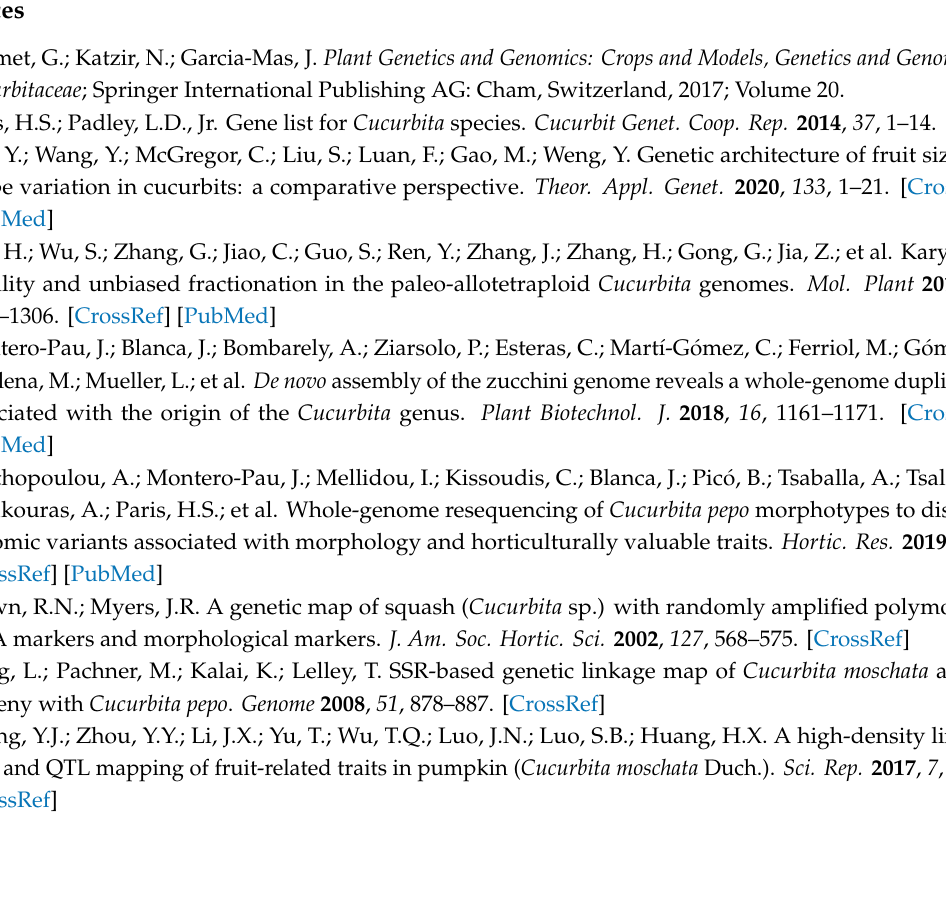
Figure S1: Trait for flesh color and cream-colored spots on the pericarp, Figure S2: Schematic representation of measurement of fruit-size related traits, Figure S3: Frequency distributions of the traits scored for the F 2 population of ‘TN 6’ × ‘Shishigatani’-K, Figure S4: A linkage map of the F 2 population (‘TN 6’ × ‘Shishigatani’-K). Table S1: List of traits analyzed, and the phenotypic values of the F 2 population and the parental lines, Table S2: List of Cucurbita simple sequence repeat (SSR) markers localized on the linkage map in this